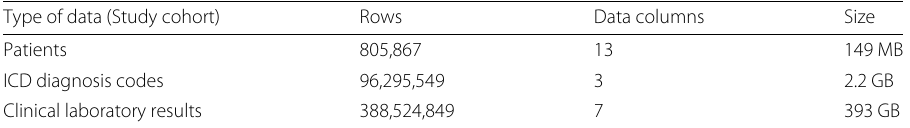
Table 1 Size and amount of data per file used Type of data (Study cohort)